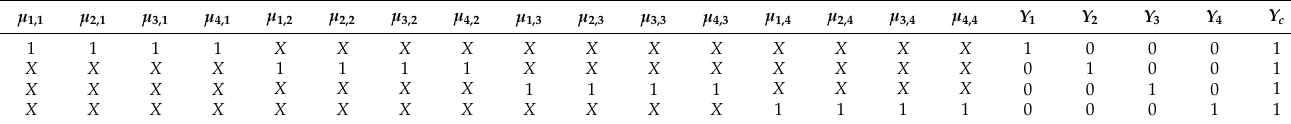
Table 18. Rules associated with the estructure of Figure